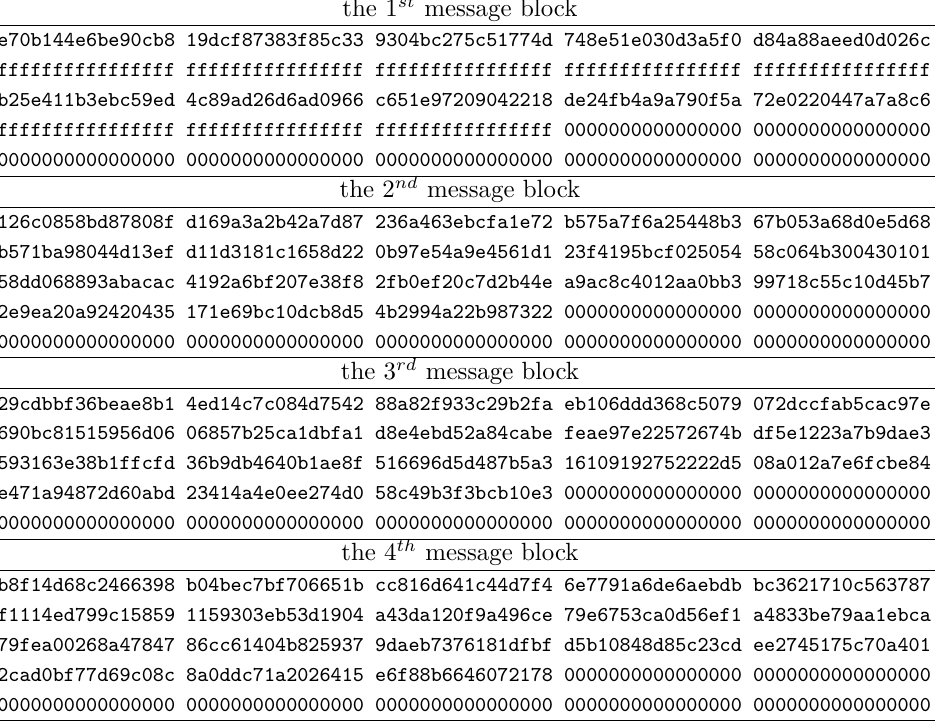
Table 9: One instance of preimage of 3-round Keccak-224 (in little-endian order). the 1 st message